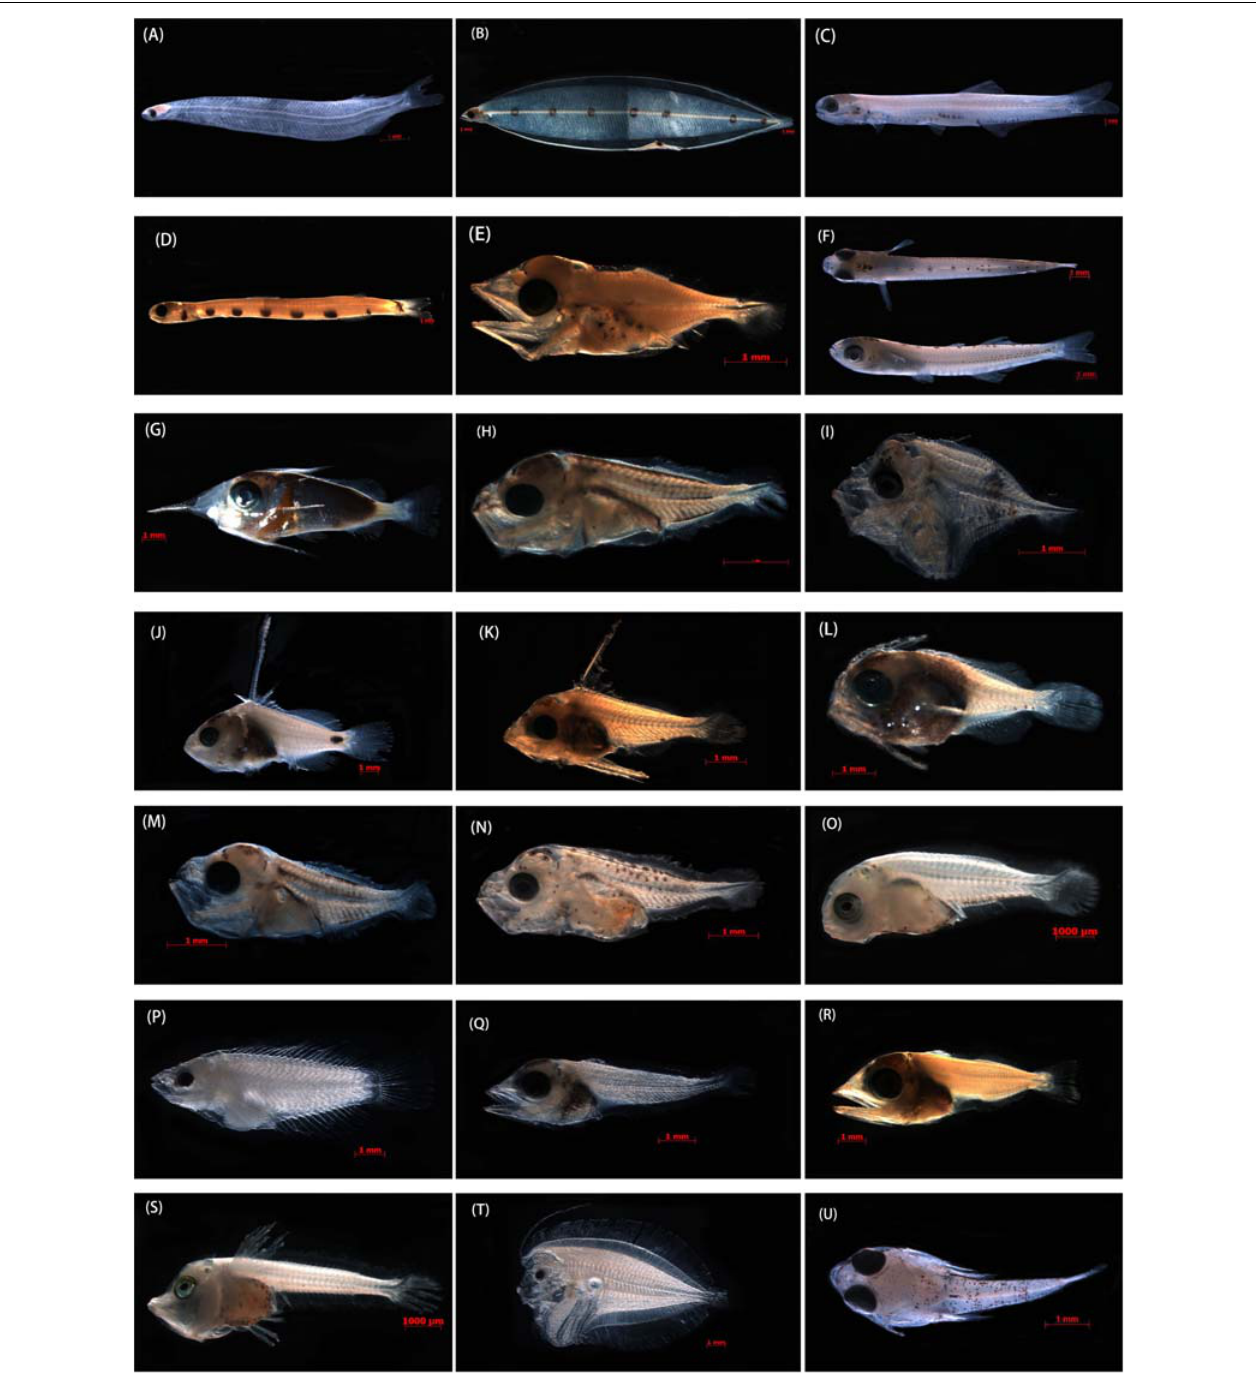
FIGURE 2 | Photographs of the specimens that produced good-quality sequences from formalin-fixed samples and that were identified to species taxa in the SCS. (A) Megalops cyprinoides , XWZ163, 10.54 mm TL; (B) Gnathophis heterognathos , GDYH1, 35.87 mm TL; (C) Encrasicholina heteroloba , XWZ54, 27.10 mm TL; (D) Trachinocephalus myops , GDYH352 26.50 mm TL; (E) Lampanyctus tenuiformis , GDYH275, 5.12 mm TL; (F) Hypoatherina valenciennei , XWZ79, 13.75 mm TL; (G) Sargocentron punctatissimum , GDYH209, 12.41 mm TL; (H) Decapterus tabl , GDYH648, 4.91 mm TL; (I) Mene maculate , BBWZ702, 3.74 mm TL; (J) Triso dermopterus , DSZ48, 12.28 mm TL; (K) Lutjanus russellii , GDYH264, 6.01 mm TL; (L) Priacanthus macracanthus , GDYH36, 6.38 mm TL; (M) Selar crumenophthalmus , GDYH193, 4.52 mm TL; (N) Trachurus japonicus , BBWZ145, 5.81 mm TL; (O) Pagrus major, FCZ10, 7.31 mm TL; (P) Thalassoma amblycephalum , DSZ32, 9.43 mm TL; (Q) Thunnus albacares , DSZ15, 7.44 mm TL; (R) Katsuwonus pelamis , GDYH24, 8.99 mm TL; (S) Lepidotrigla alata , FCZ019, 8.32 mm TL; (T) Bothus pantherinus , DSZ43, 11.46 mm TL; and (U) Callionymus curvicornis , XWZ101, 6.29 mm TL.